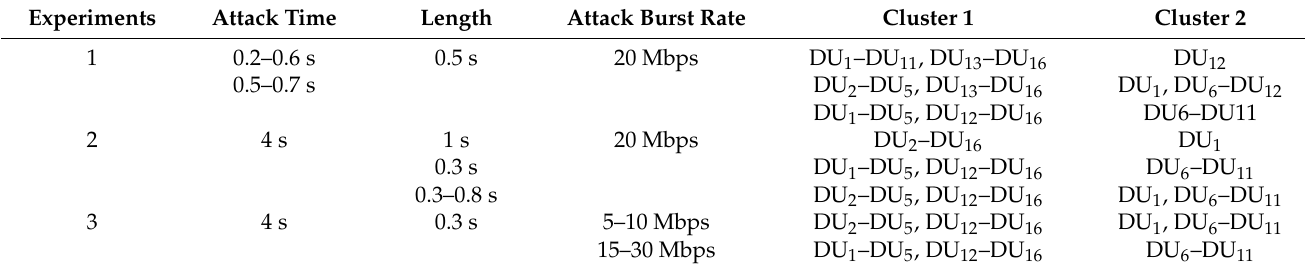
Table 2. The cluster